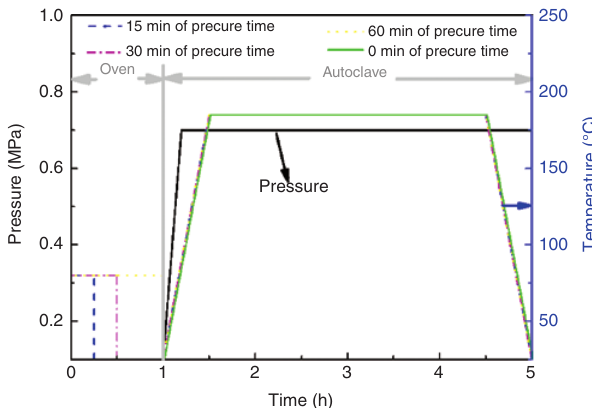
Figure 1: Precure and cure cycles used to process carbon/ benzoxazine